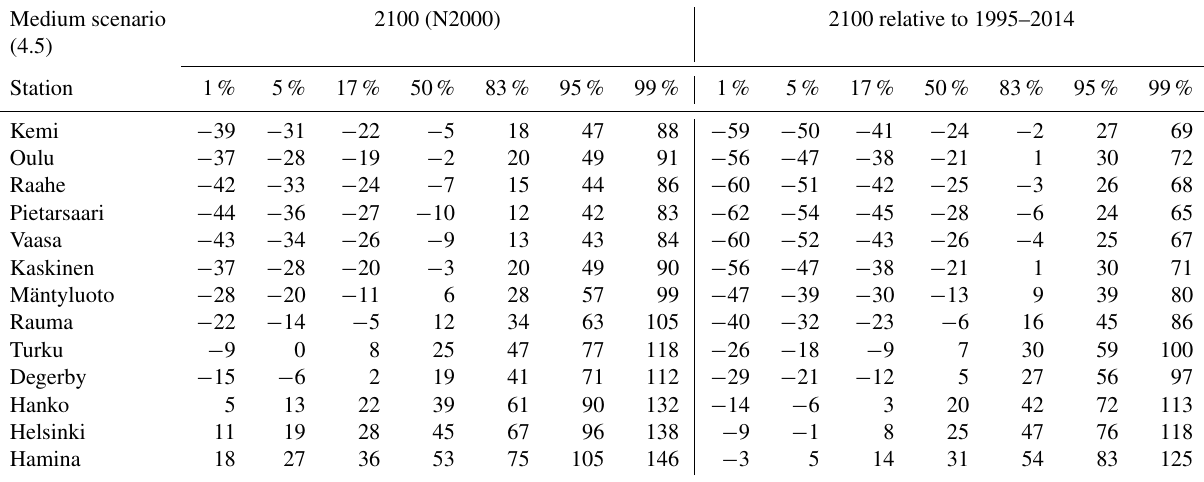
Table A3. Projected mean sea level (centimetres) at the Finnish tide gauges in 2100 under the medium-emission scenario